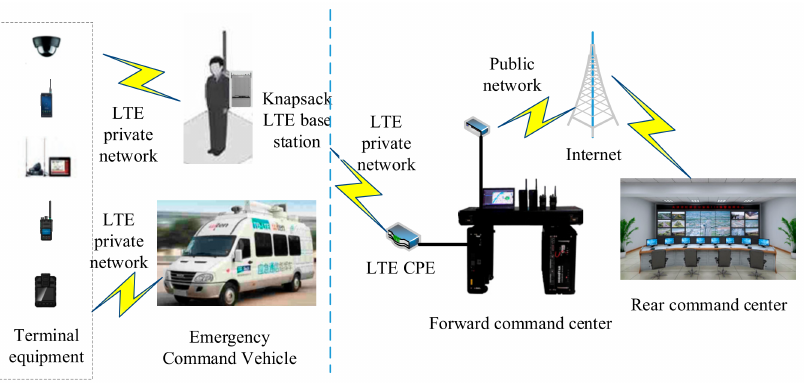
Figure 11. System topology of the “LTE + Mesh”